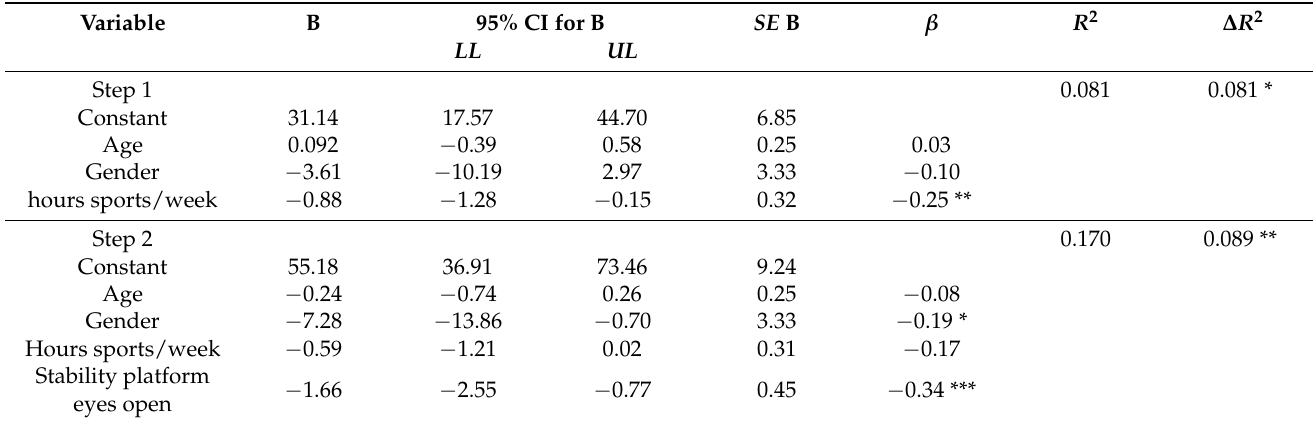
Figure A1. Correlation between the balance performance in the eyes-open condition (seconds in correct position) and perspective-taking skills (OPT task, mean deviation error in degree). N = 133 ( n = 38 balance group, n = 37 endurance group, n = 58 sedentary group). Confidence bands indicate 95% confidence intervals. Table A1. Hierarchical regression model for perspective-taking abilities (OPT